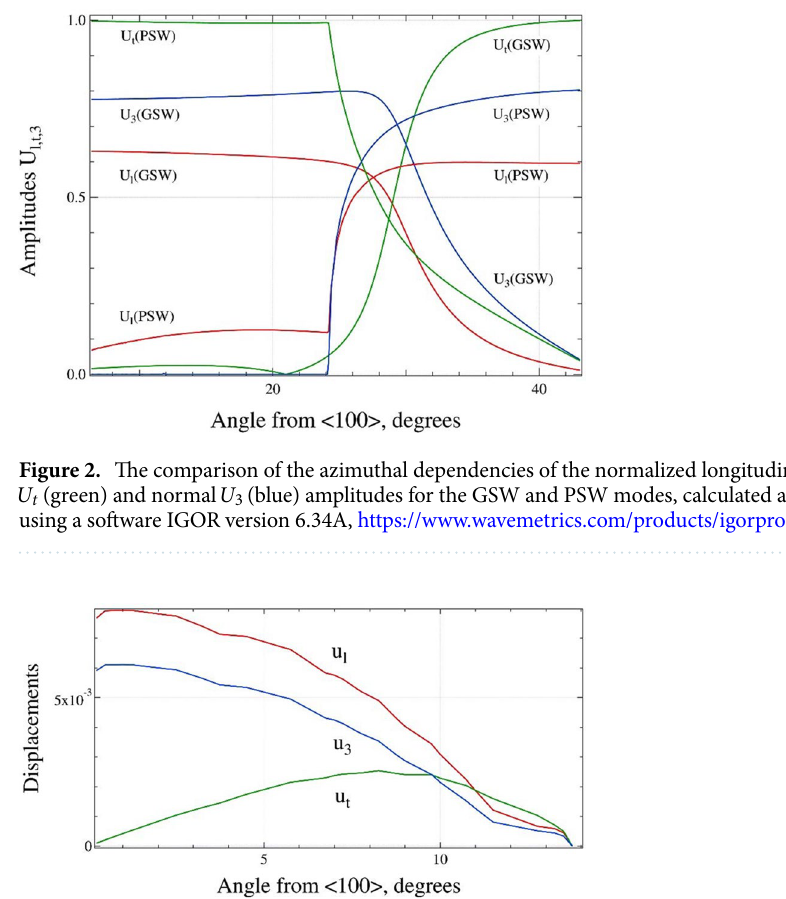
Figure 3. The azimuthal dependencies of the displacements (longitudinal—red, transversal—green and normal—blue). (graph created using a software IGOR version 6.34A, https ://www.wavem etric s.com/produ cts/igorp